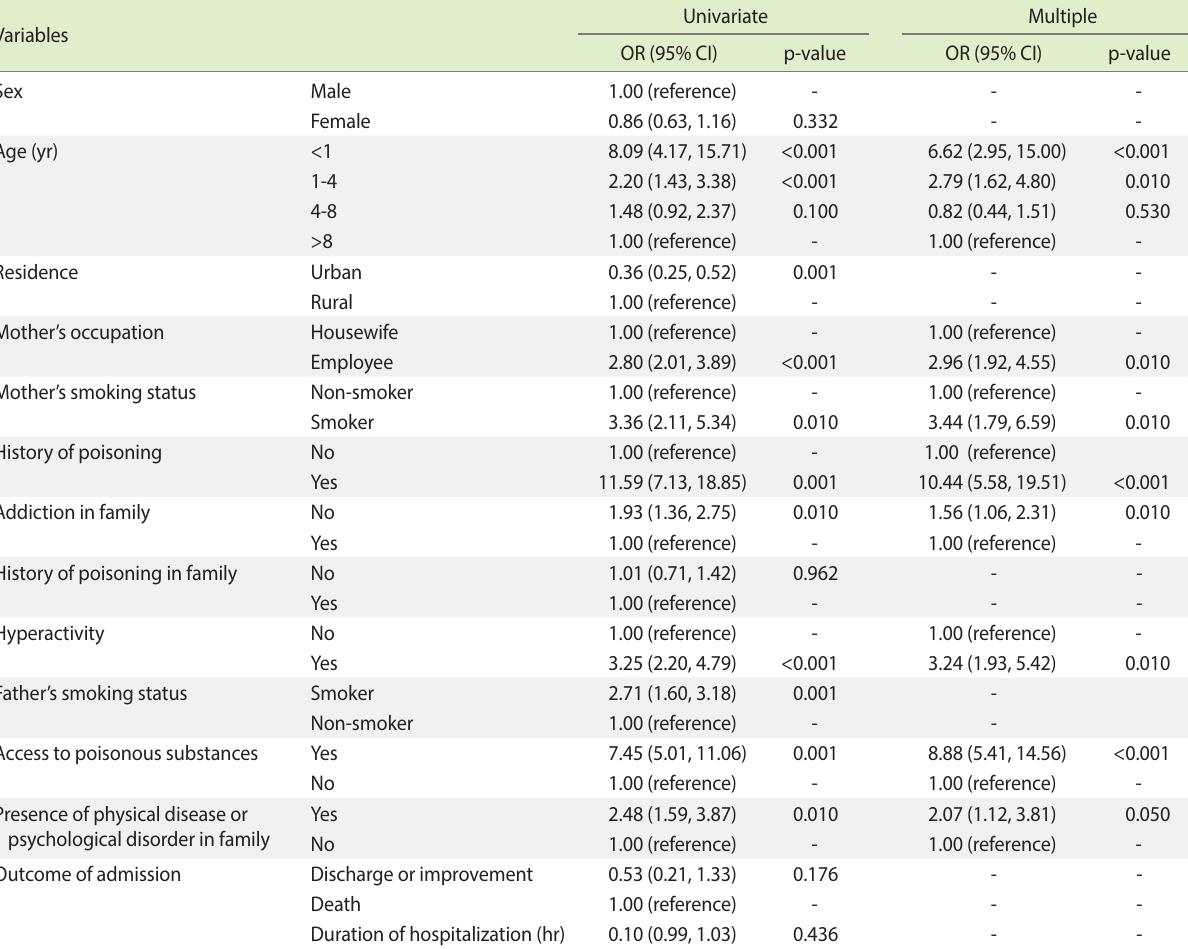
Table 2. Risk factors for childhood poisoning by regression analysis